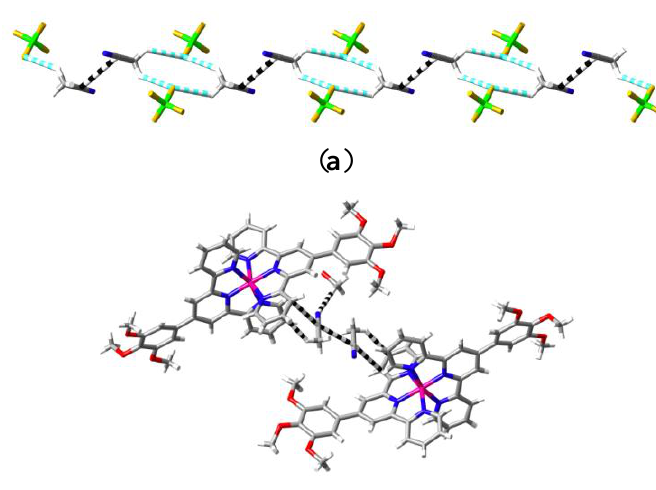
Figure 3. ( a ) Portion of the chain formed by bridging of pairs of antiparallel CH dipoles by CH…F interactions (blue and white dashed lines) with F…H 2.570(2) and 2.564(2) Å for the two bonds of a given F. The nitrile-C…C-nitrile contacts, 3.267(6) Å, are shown as black and white dashed lines; ( b ) π-interactions involved in the bridging of two cations with Co…Co 13.947(6) Å by every one of the CH of the nitrile- N …HC interactions involving a methoxyl group of a third adjacent cation is also